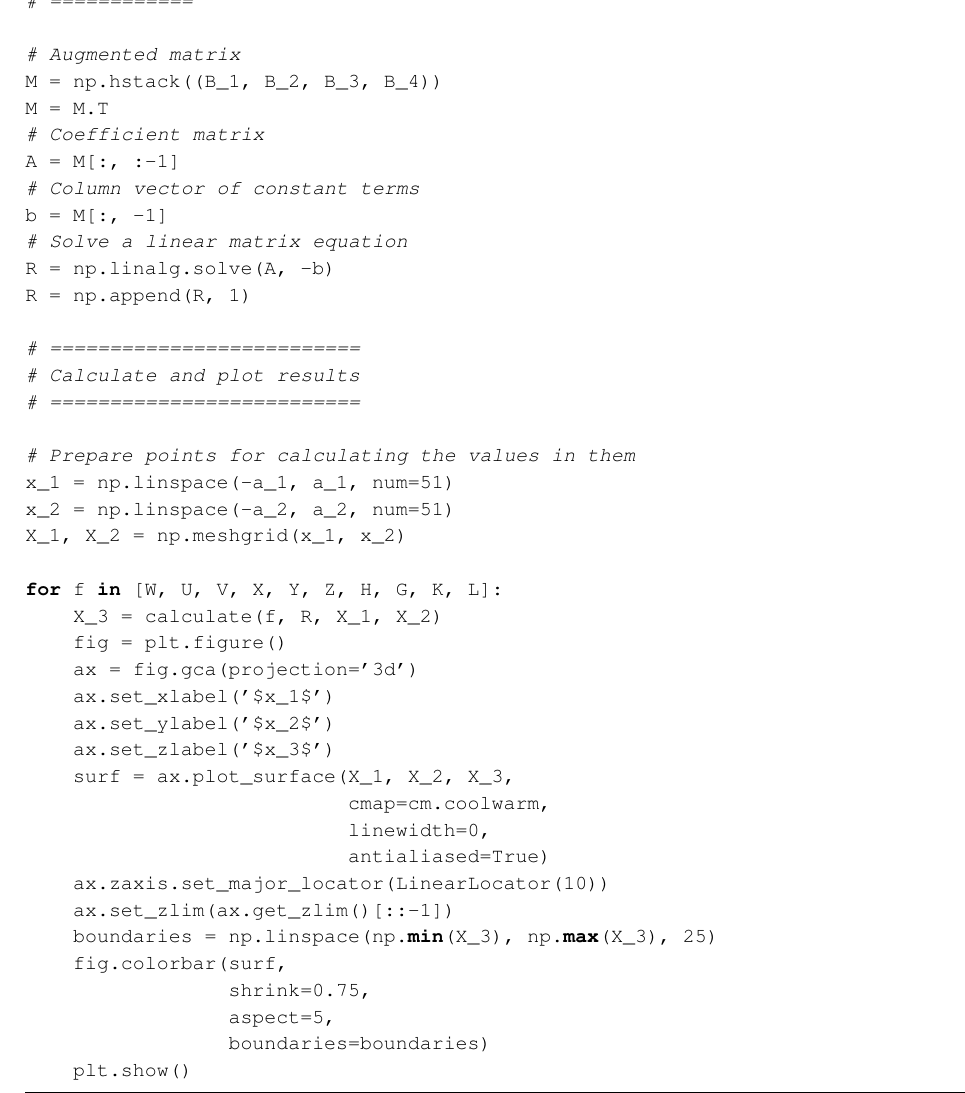
fig.colorbar(surf, shrink=0.75, aspect=5,